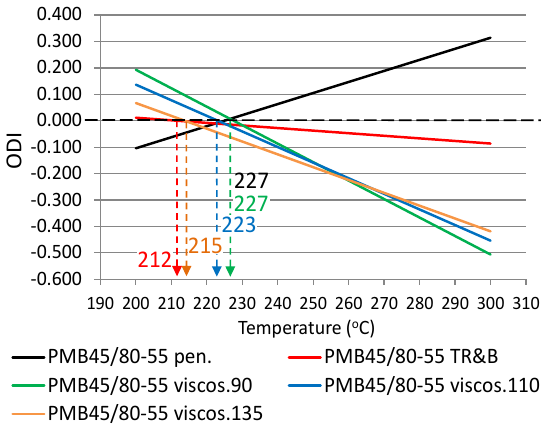
Figure 6. Overheating Degradation Index for PMB65/105-60 and determination of temperature T (ODI) .